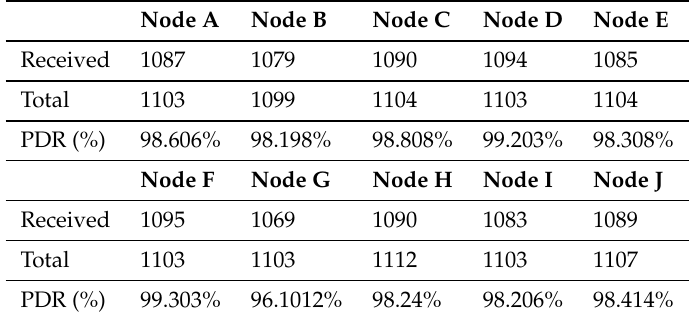
Table 5. Traffic test: saturation of the sink